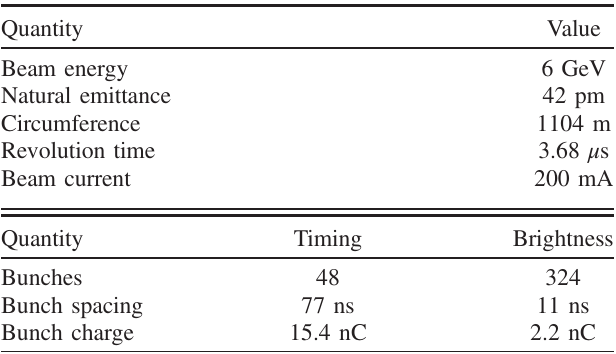
TABLE I. APS-U storage ring parameters for two modes of operation.